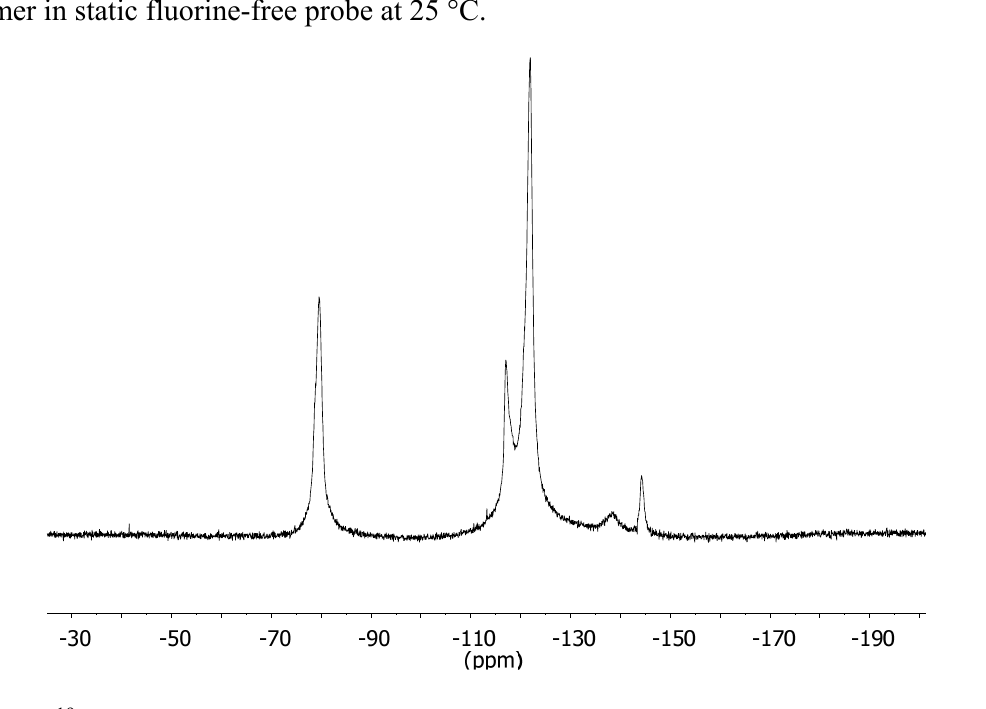
and D values, Viscosities and calculated radii for Nafion ionomer Table 1. 19 F NMR T 1 solutions heat-treated at 25, 50, and 80